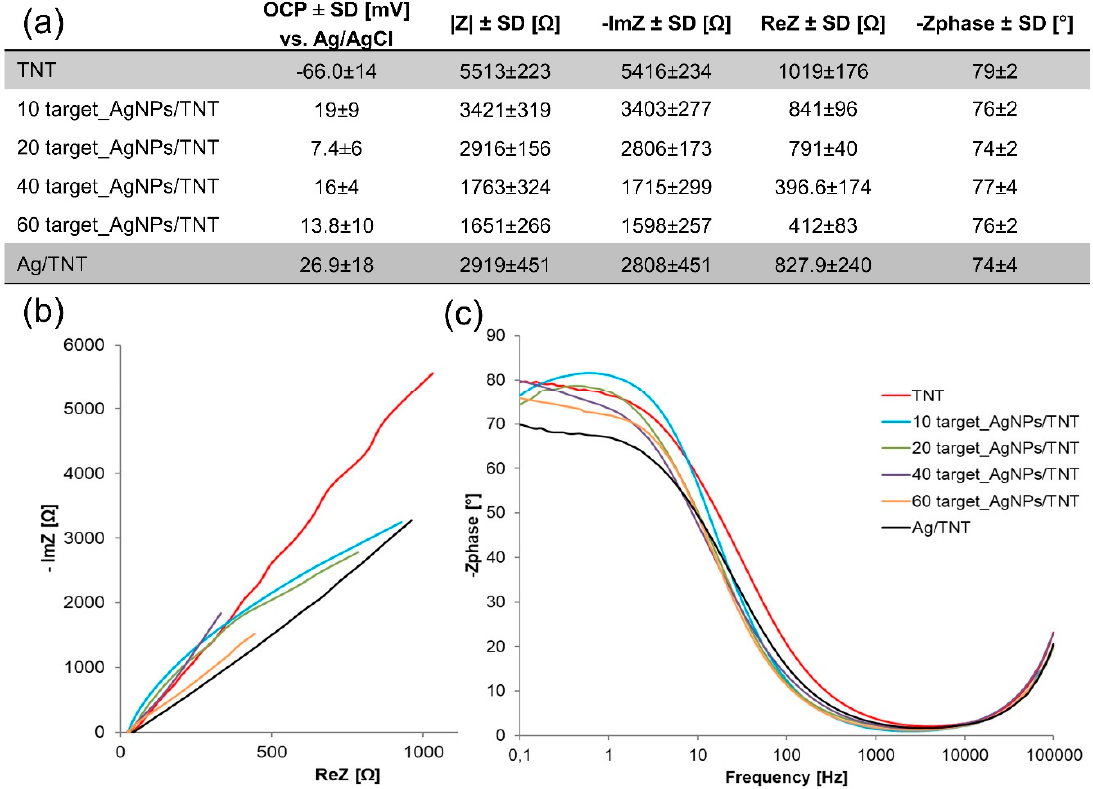
Figure 10. Summary of impedance parameters ( a ), Nyquist ( b ) and Bode ( c ) plots of AgNPs / TNT platforms di ff ering in time of sputter deposition of silver and reference layers: TNT and Ag / TNT. Spectra were recorded in the PBS solution (0.01 M, 10 ml, pH 7.4) over the frequency range 0.1–10 5 Hz with amplitude 10